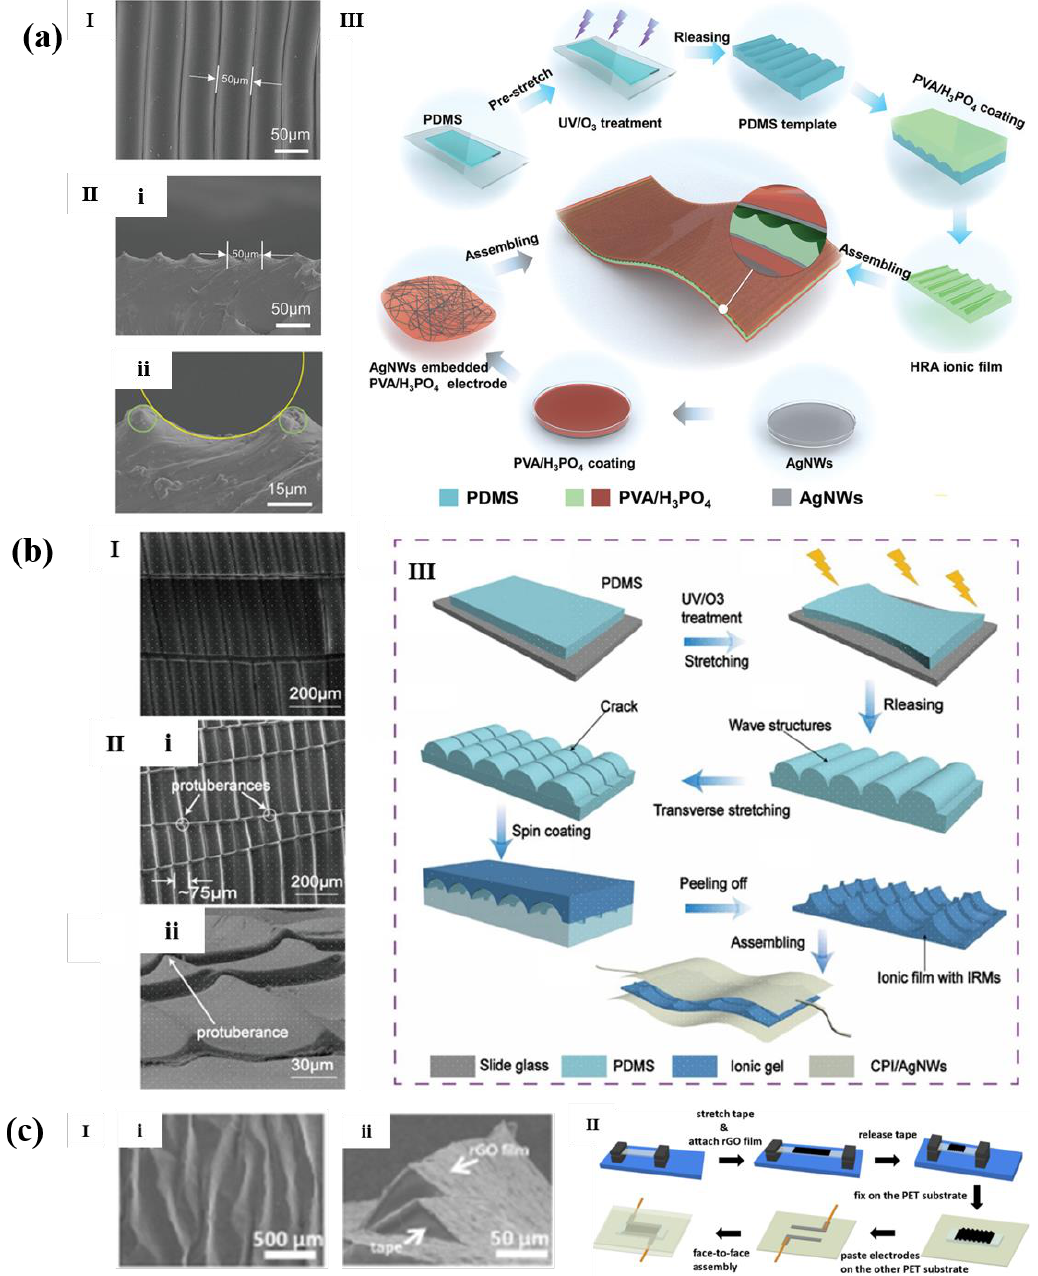
Figure 9. ( a , I ) SEM image of the patterned PDMS template; ( II , i ) A cross-sectional view of the templated PVA/H 3 PO 4 HRA film, and ( ii ) contour detail of HRA; ( III ) The fabrication procedure for the pressure sensor [79]. ( b , I ) SEM image of the PDMS template with 40% pre-stretching; ( II ) SEM image of ( i ) the dielectric layer with IRM and ( ii ) its tilt-view; ( III ) Schematic illustration of the procedures of the sensor [80]. ( c , I ) SEM image of ( i )the surface of wrinkled structure, ( ii ) the cross-section of the wrinkled structure; ( II ) Fabrication process of the rGO-based pressure sensor with wrinkled structure [81].